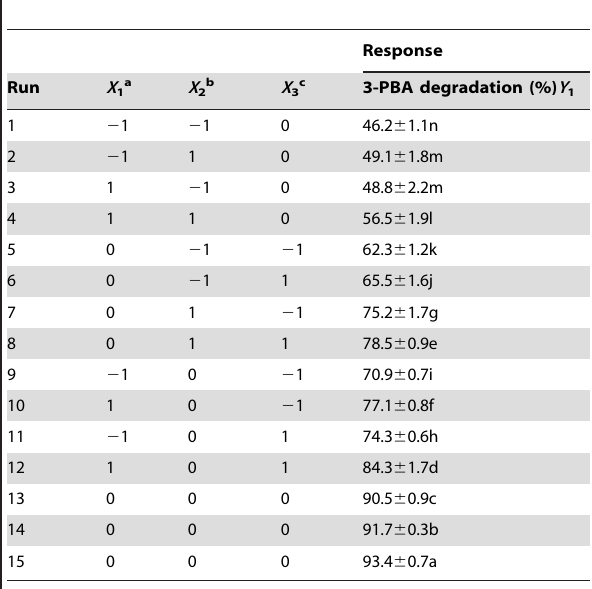
Table 1. Box-Behnken experimental design matrix and the response of dependent variable for 3-PBA